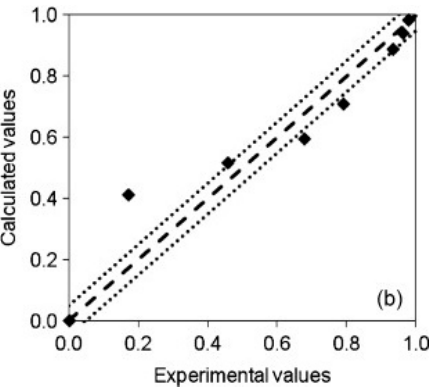
Figure 16. Normalized parity plot of experimental values of ethanol extracted by supercritical drying of a starch aerogel. Adopted with permission from [33].